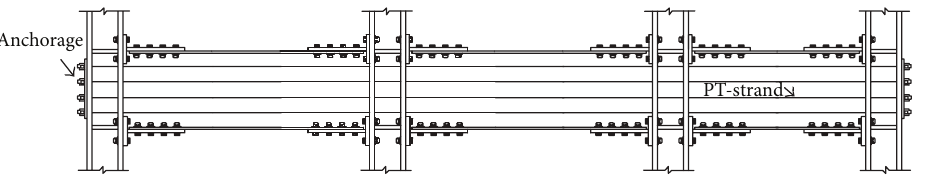
Figure 1: Moment resisting frame with PTTC connections.